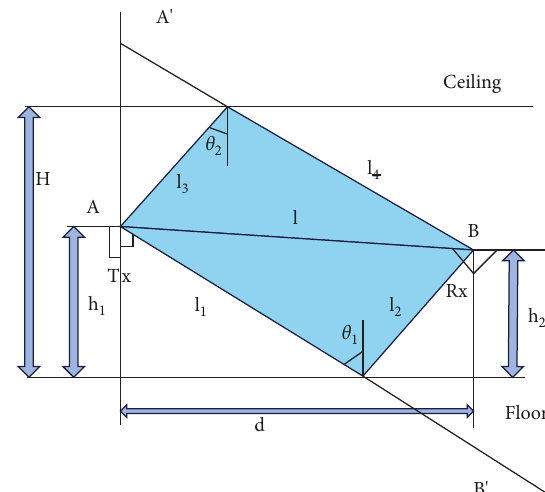
Figure 2: Geometrical optics analysis